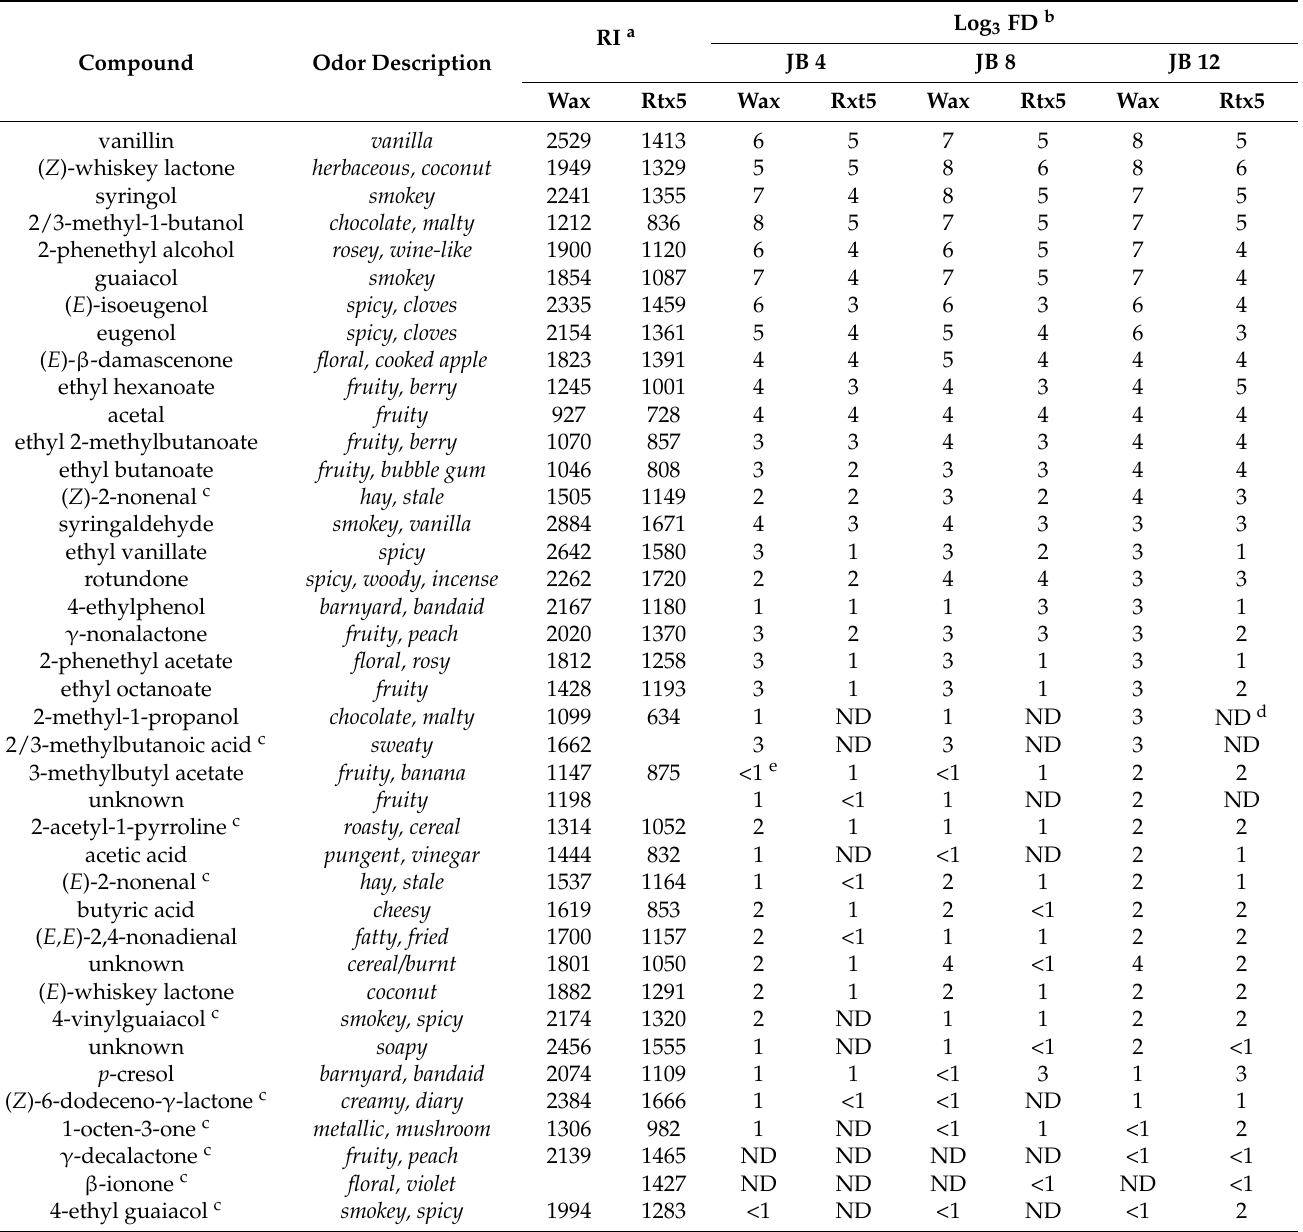
Table 3. Potent odorants determined by aroma extract dilution analysis of bourbon whiskeys aged for 4, 8, and 12 years.